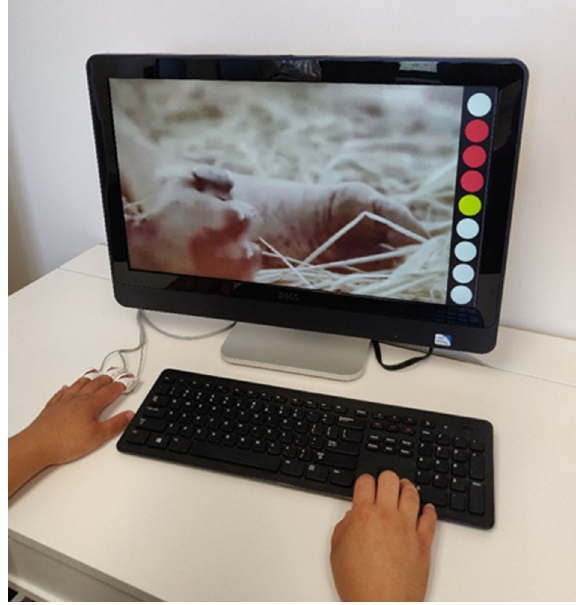
Fig. 1 Experimental setup. The physiological sensors worn by participants and stimulus